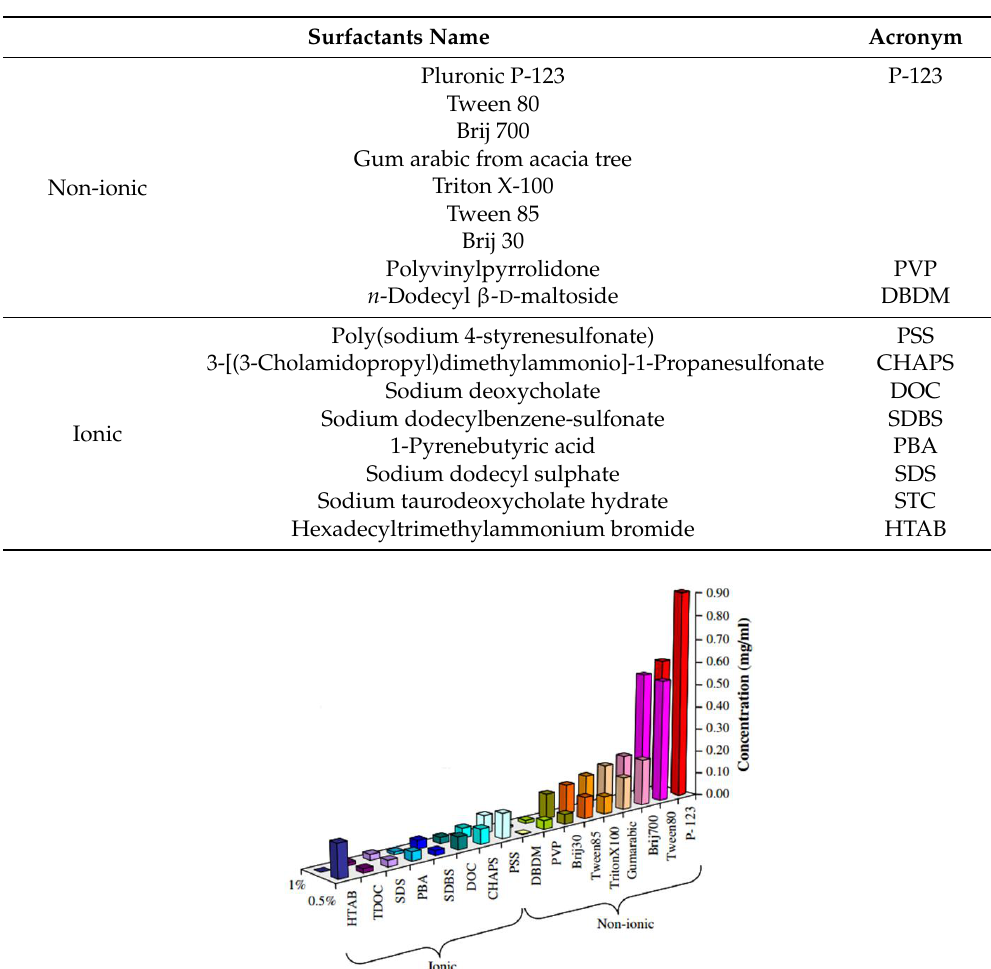
Table 2. Surfactants and their acronyms used throughout the text [116]. (Reproduced from [116] with permission; Copyright 2011 Elsevier).